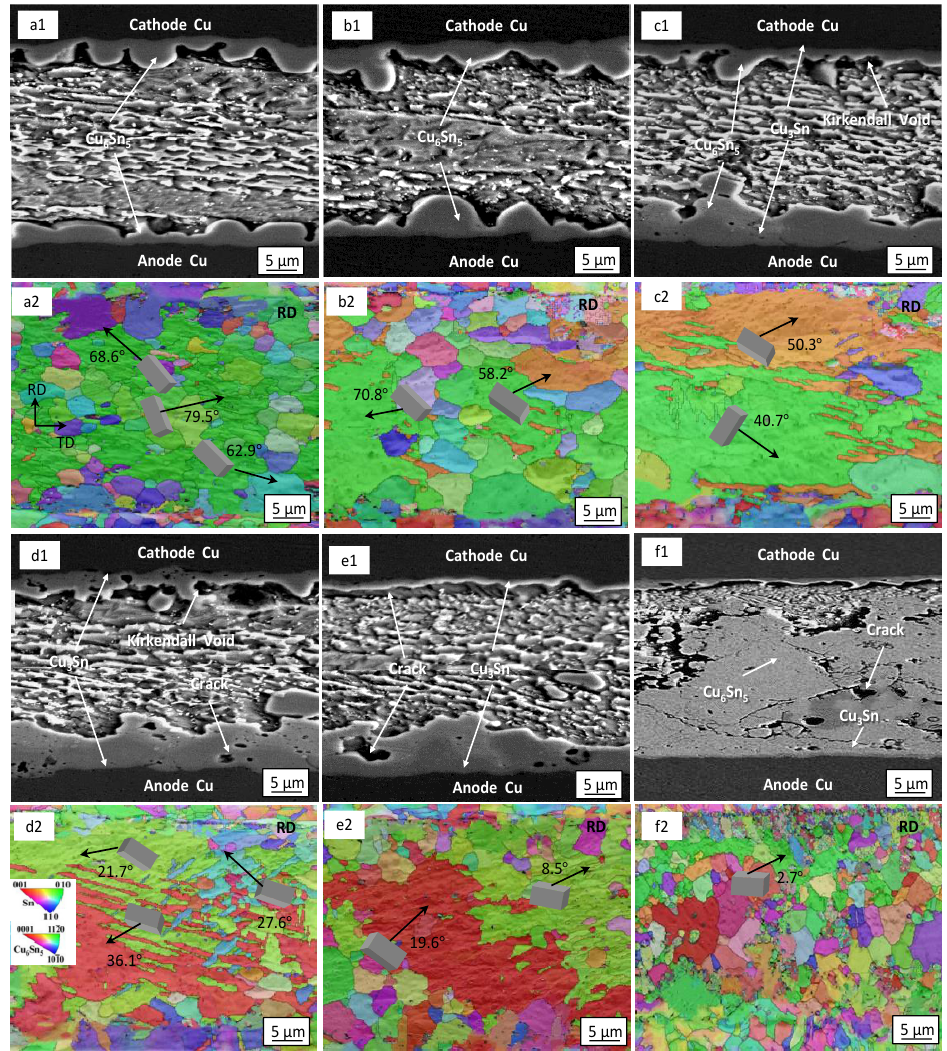
Figure 6. Microstructure and EBSD orientation of solder joints in the current loading (j = 7 × 10 3 A/cm 2 ) process: ( a1 – f1 ) 50 h, 100 h, 150 h, 200 h, 250 h, 350h; ( a2 – f2 ) corresponding crystal